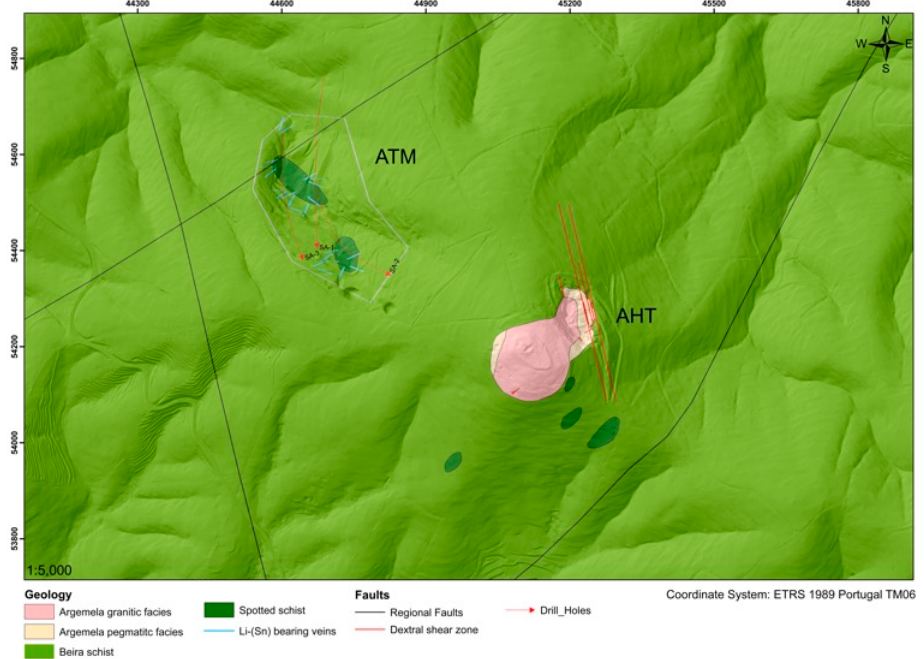
Figure 2. Geological map of the Argemela district showing the Argemela Tin Mine (ATM) and Argemela Hill Top (AHT) systems (modified from Inverno and Ribeiro [31], Charoy and Noronha [5] and Michaud et al. [33]).